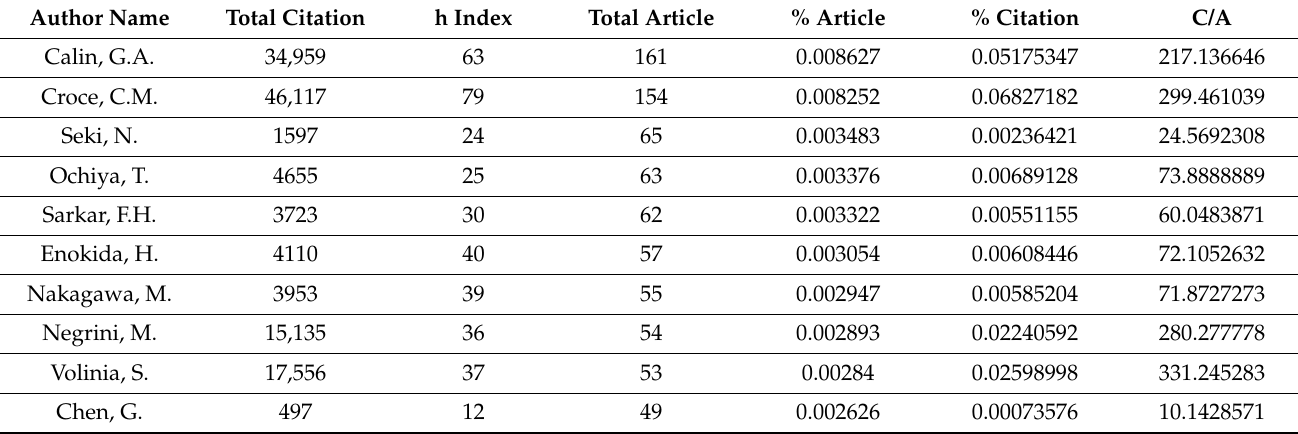
Table 6. Top 10 cited articles on miRNA in cancer (2003–2019).